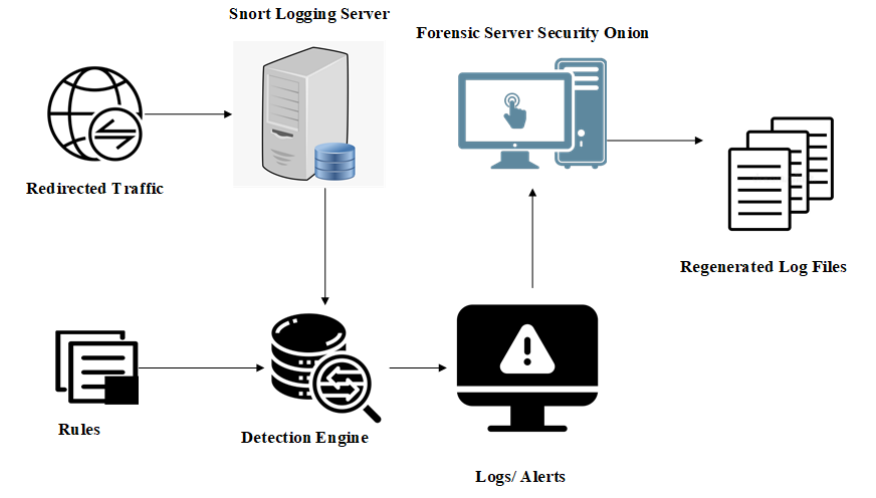
Figure 6. Integration of logging server and forensic